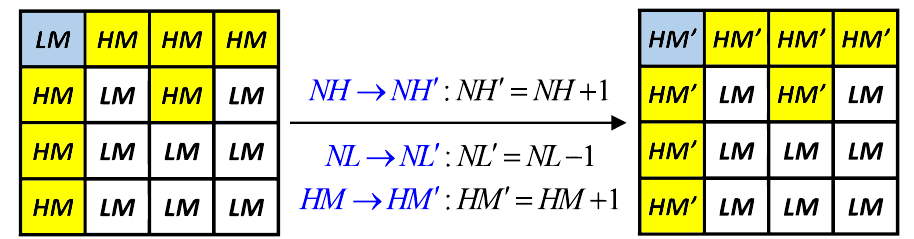
Figure 5. Illustration of compulsorily modifying parameters to satisfy search constraints and maintain hidden function values simultaneously.